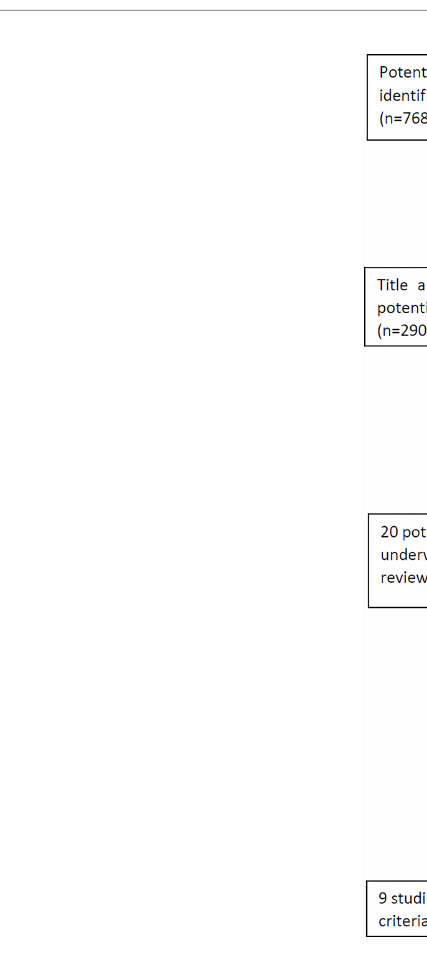
FIGURE 1 | Study identi fi cation and literature review